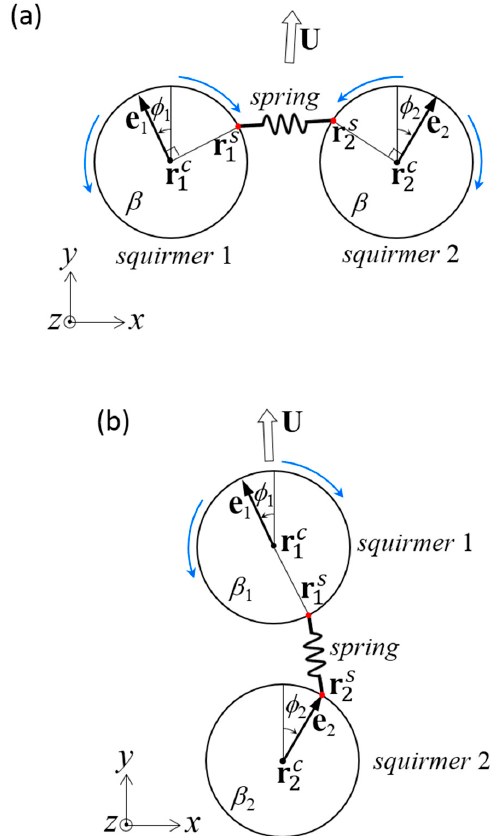
Figure 6. Problem settings for a dumbbell squirmer connected by a spring. The spring was connected between r s and r s on the surface of squirmer 1 and 2, respectively. Squirmer i had orientation vector e i , 2 1 squirming mode β i , angle from the y -axis φ i , and the center position r c with swimming mode β were connected side-by-side. ( b ) Two squirmers connected fore and